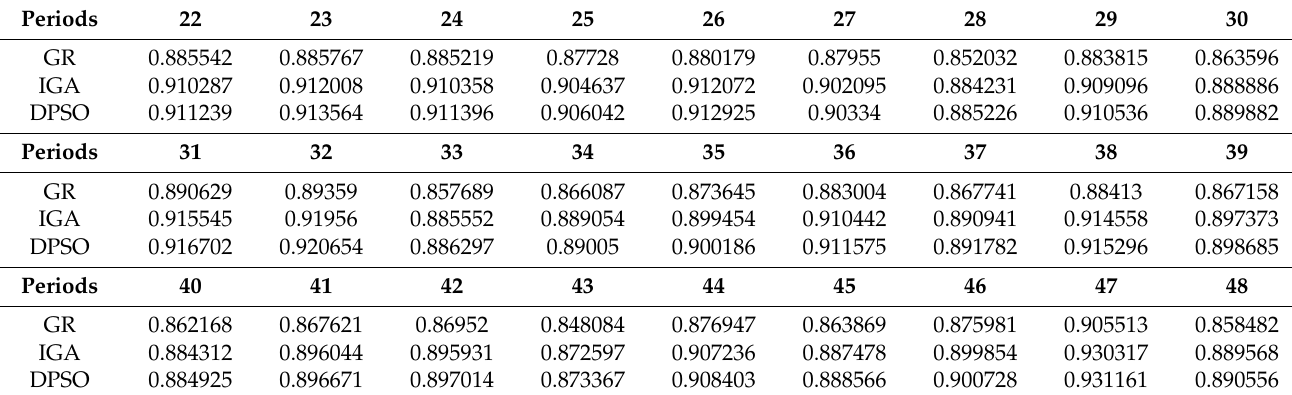
Figure 5. Two-algorithm evaluation-value comparison chart of 100 tests.